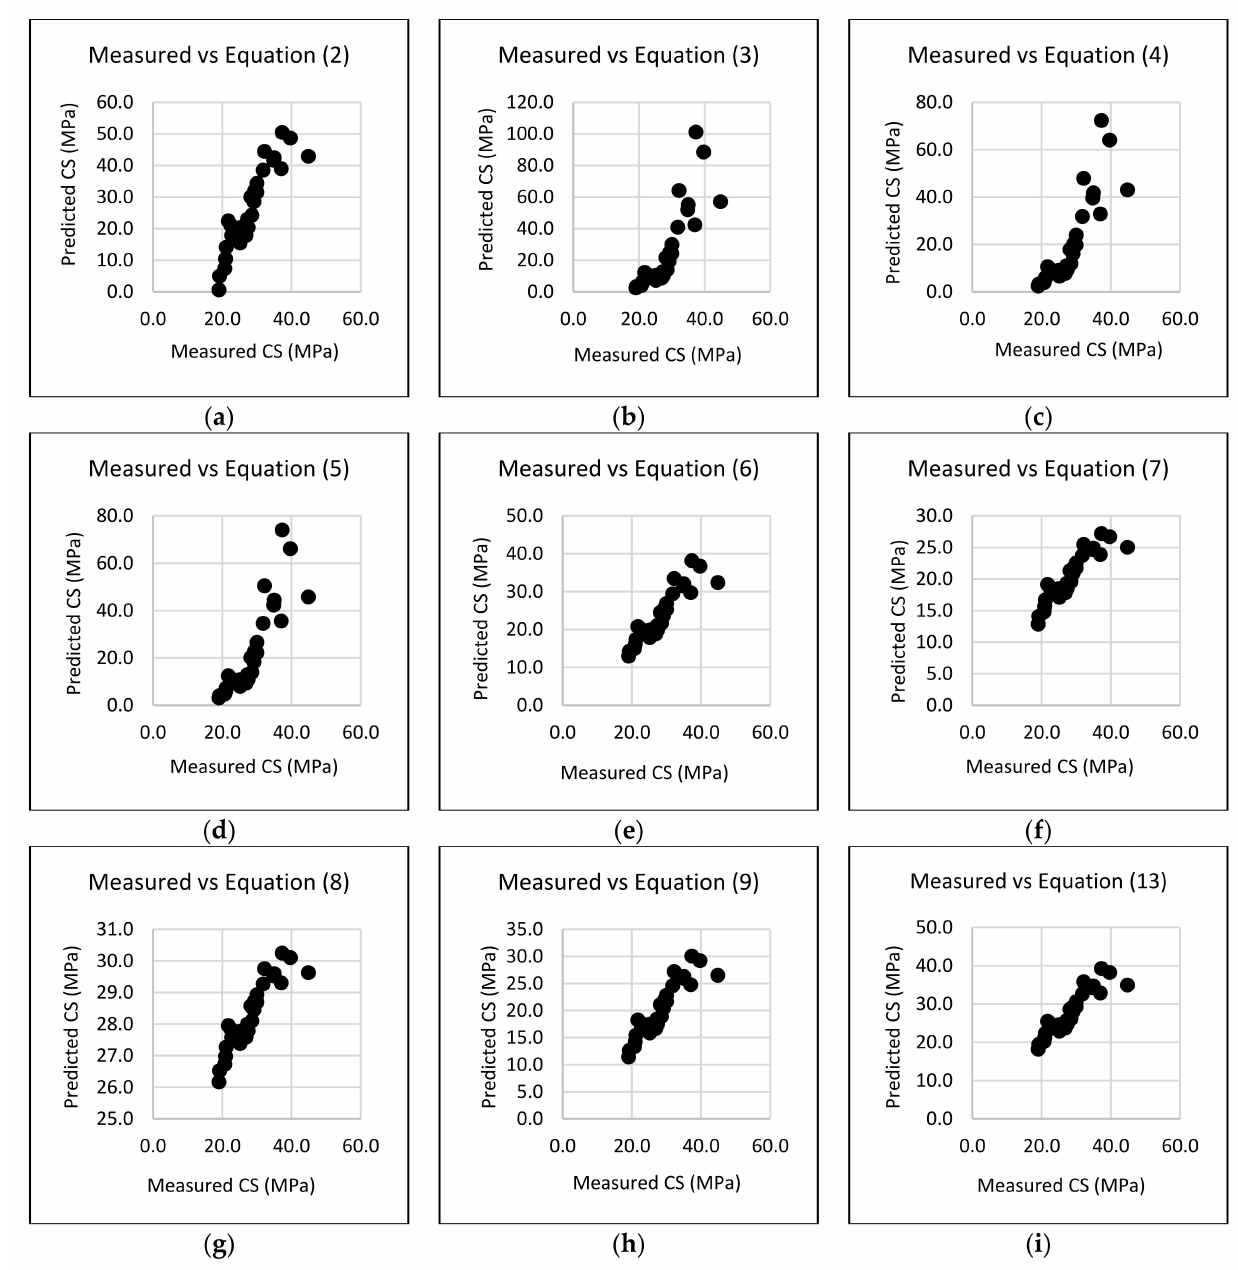
Figure 3. Measured vs. predicted compressive strength (CS) of PFRC specimens. ( a – i ): Measured vs. Equations (1)–(13). Table 7. The coefficient of variation ( COV ) for PFRC